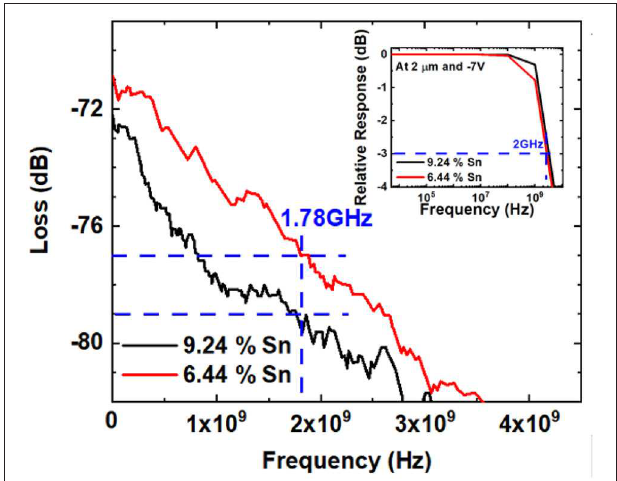
FIGURE 6 | Electrical bandwidth of 1.78 GHz for both devices with mesa’s diameter of 100 µ m; (inset) simulated results for optical bandwidth of 2 GHz for both devices.